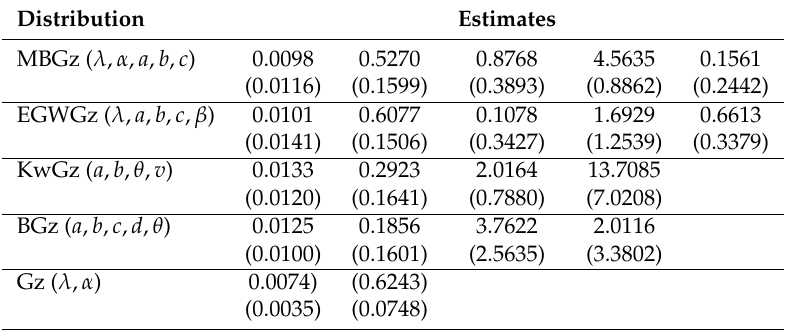
Table 3. MLEs (standard errors in parentheses) for Dataset